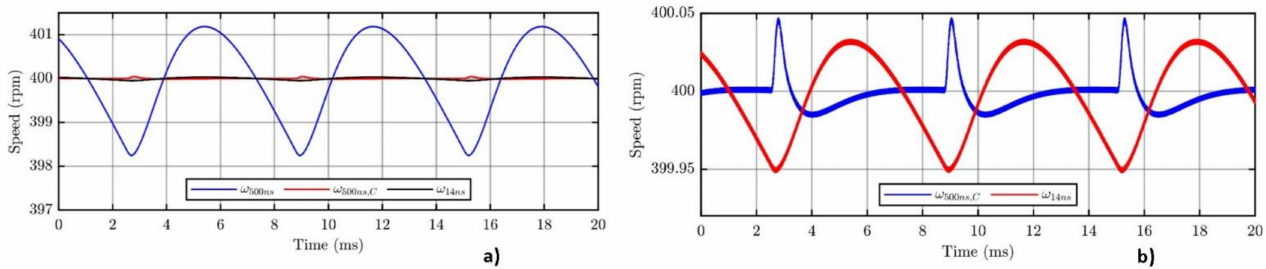
Figure 17. Dead time effect in the speed ripple. ( a ) Dead time equal to 500 ns compared with dead time of 500 ns with compensation and dead time reduced of 14 ns. ( b ) Magnified view of Figure 17a for speed ripple comparison at 14 ns of dead time and 500 ns dead time with software